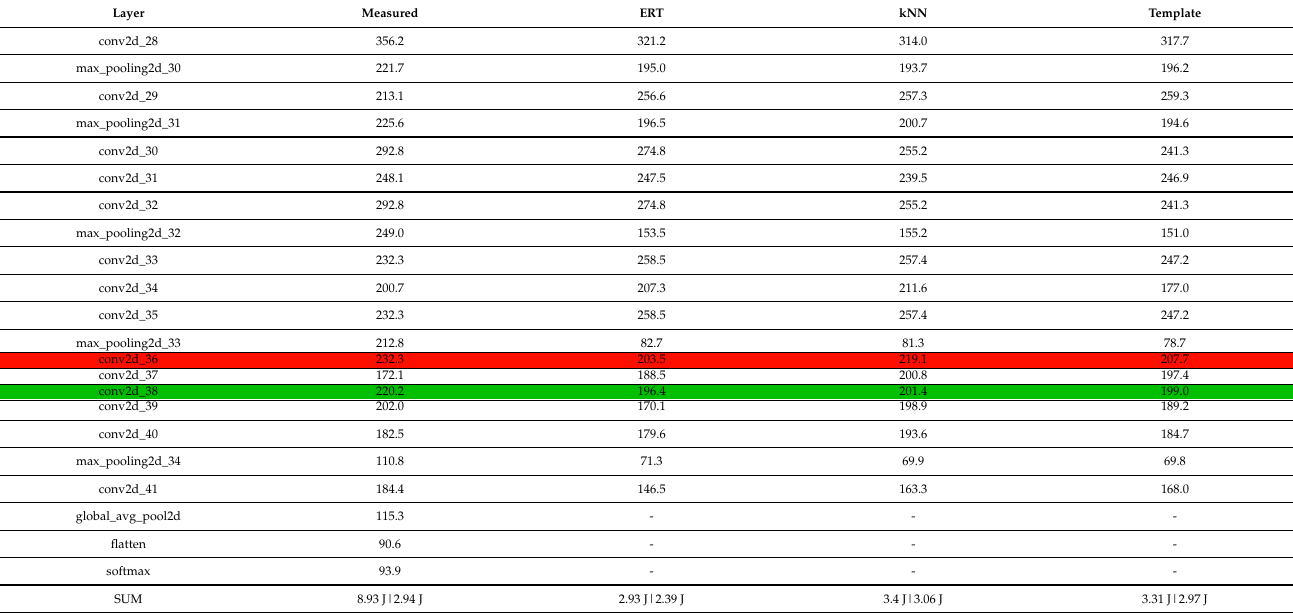
Table 6. Comparison of the layerwise measurements of the execution power with the predictions of the different approaches. The layer configuration of the convolutional layer with the large un- derestimation of the inference latency is marked in red, the green row represents a similar layer which achieved a significantly shorter inference latency. The inference power was measured and predicted in Watt. The last line compares the total inference times with and without the inclusion of the erroneous layer.